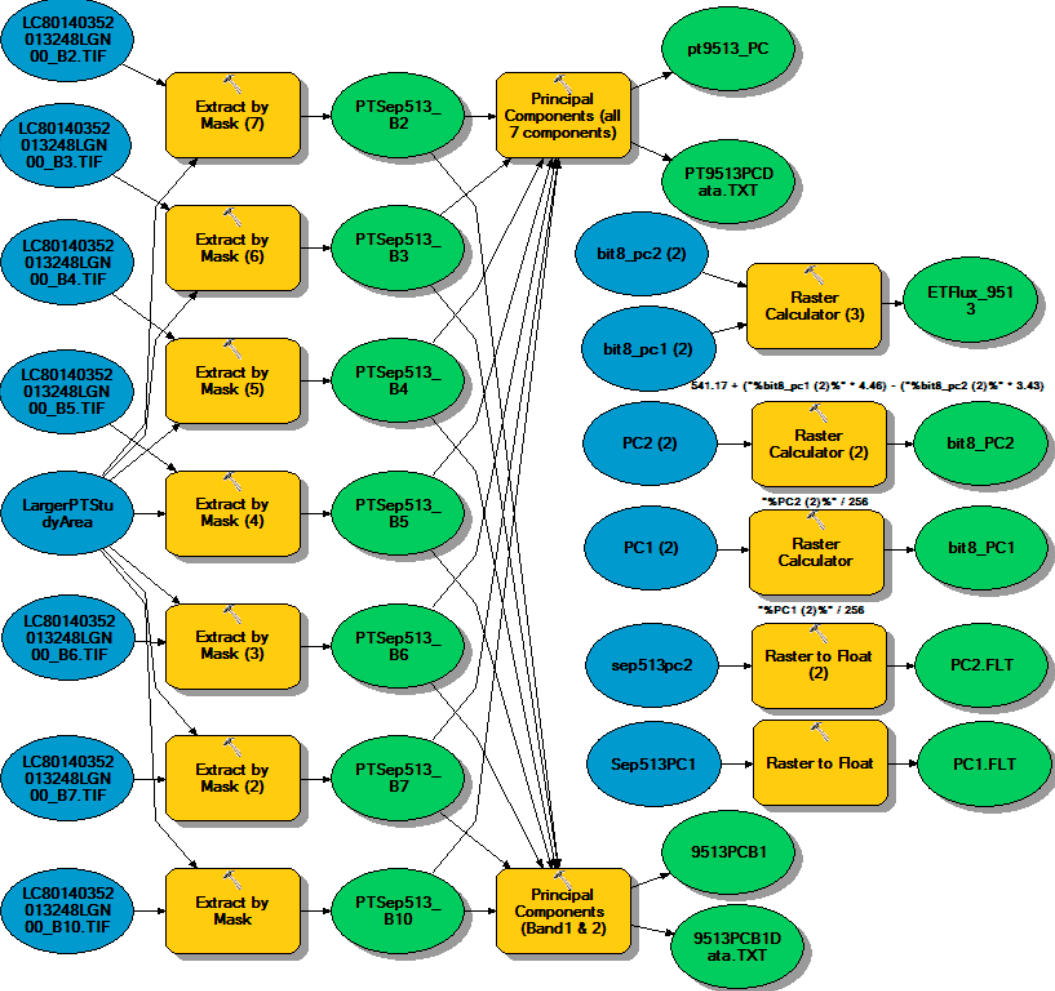
Figure 2. Automated geospatial model developed in ArcGIS ModelBuilder to be used by end-users to develop a single date ET Flux map of a study area.